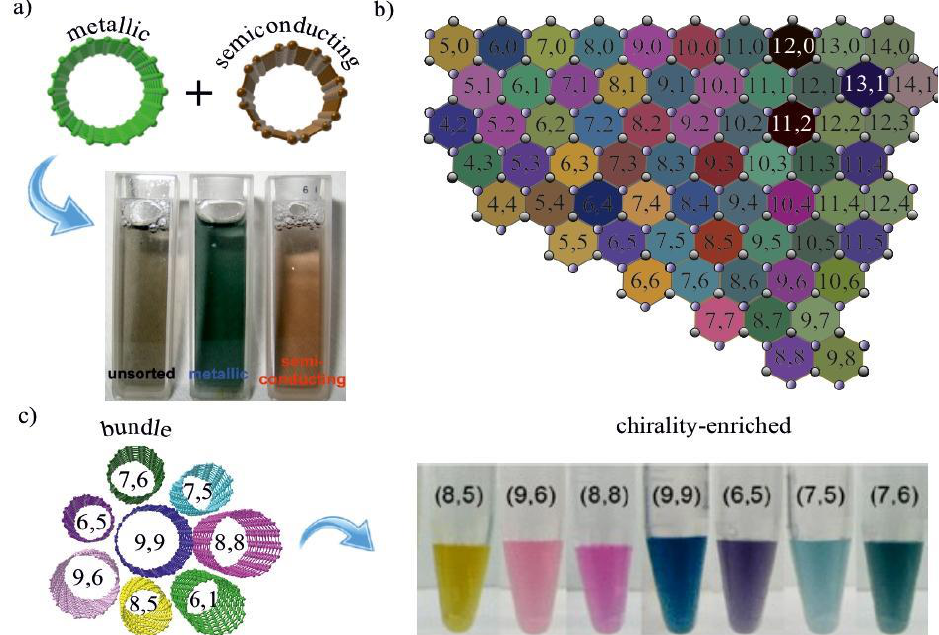
Figure 12. ( a ) The various types of carbon nanotubes are present in the unsorted samples and the corresponding photograph. ( b ) A map illustrates the colors of different types of carbon nanotubes with unique chiral indexes (n,m). ( c ) A mixture of different chirality SWCNTs in a bundle. Photo- graph of a few purified DNA-dispersed single-chirality SWCNTs [83]. Copyright 2016, American Chemical Society.